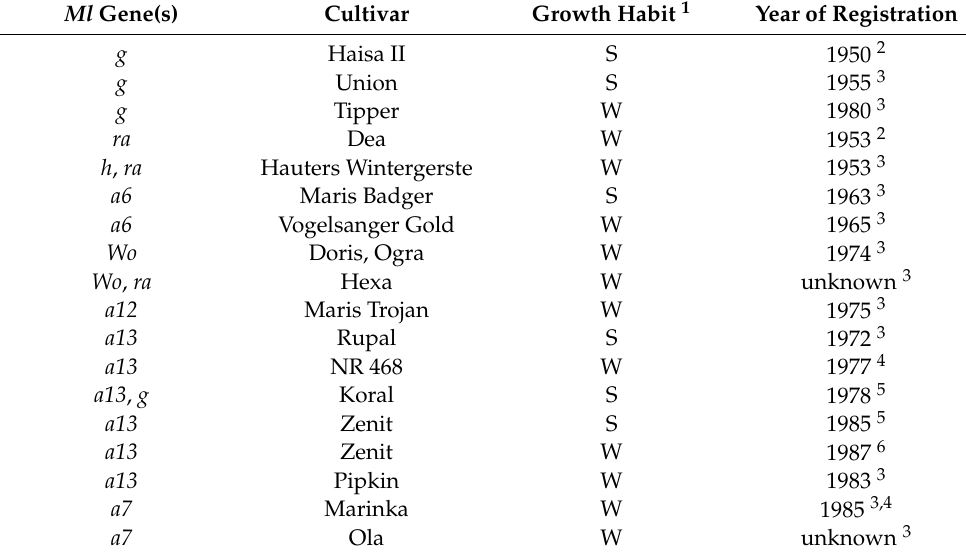
Table 3. First recorded use of specific resistance genes to powdery mildew in the breeding of European barley